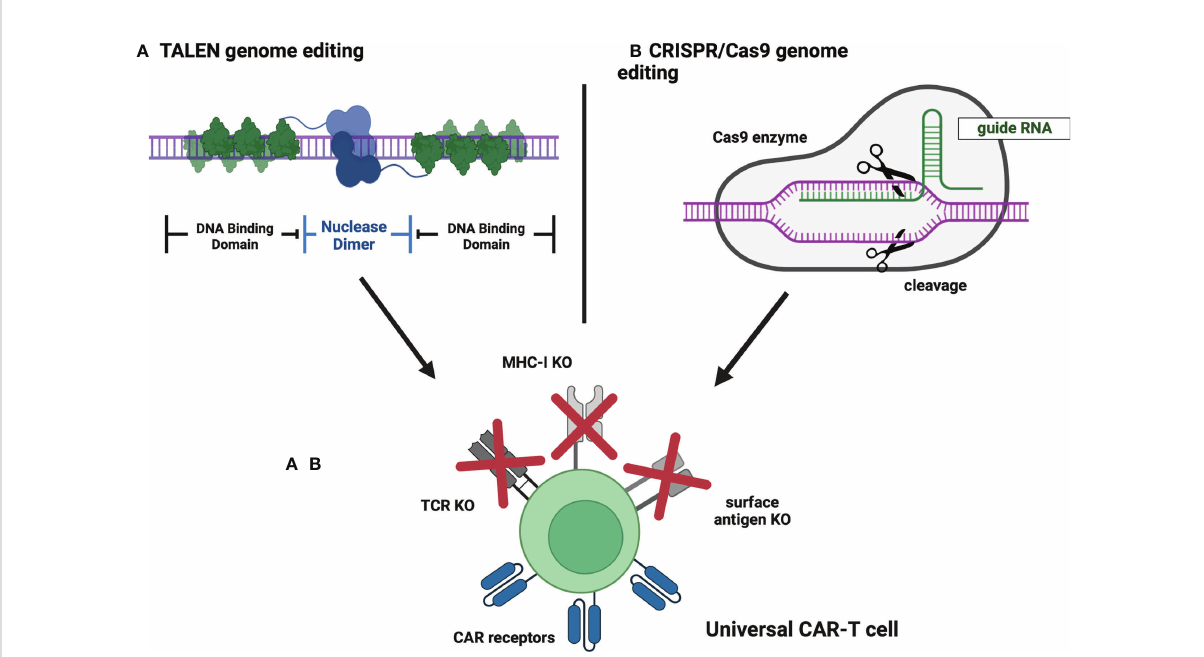
FIGURE 5 Universal CAR-T cells – genome editing strategies. (A) TALEN genome editing. TALEN is a genome-editing system in which a targeted DNA sequence is recognized by a pair of individually designed DNA-binding domains. Then, a pair of nuclease domains cause a double-stranded DNA break and subsequent knockout of the targeted gene. (B) CRISPR/Cas9 genome editing. CRISPR/Cas9 is a genome-editing system in which a targeted DNA sequence is recognized by guide RNA associated with Cas9 endonuclease that cleaves DNA strand, thus causing the knockout of a selected gene. Created with